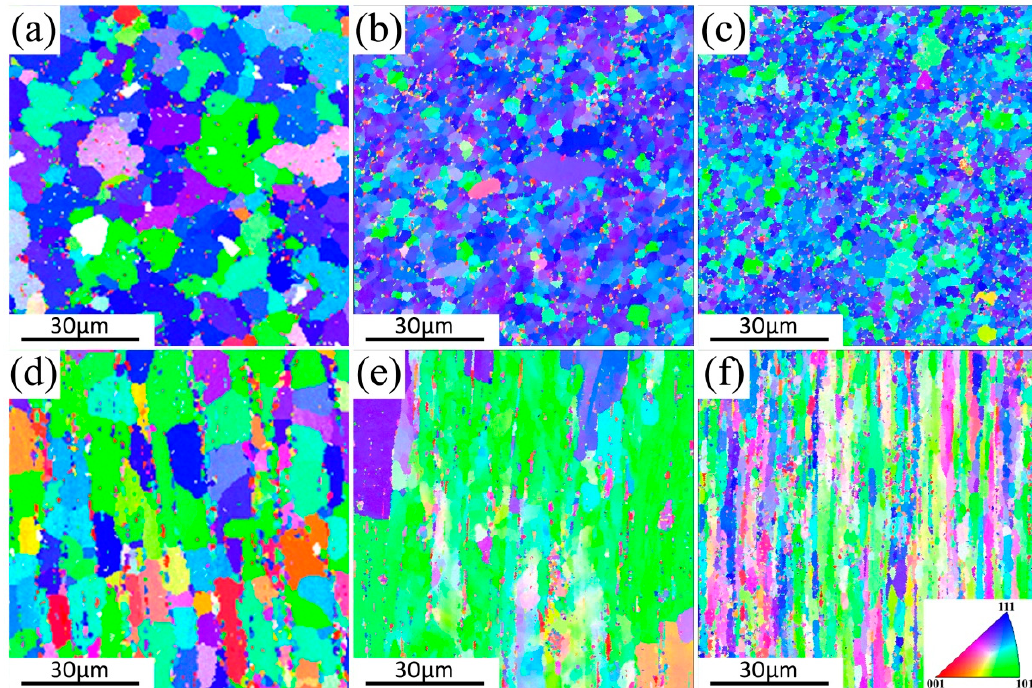
Figure 5. Inverse pole figure (IPF) maps of the NiTi (B 2 ) phase in different states, representing the preferred crystalline orientation in the normal direction (ND) of the test planes. ( a – c ) cross sections of Samples A, B and C, respectively; ( d – f ) longitudinal sections of Samples A, B and C, respectively.